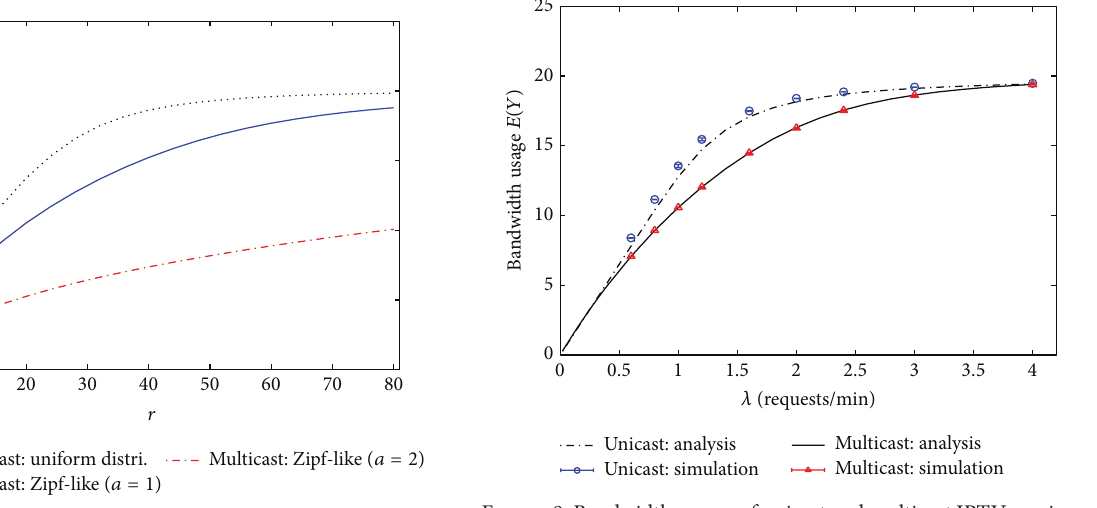
Figure 7: Bandwidth usage of multicast IPTV services under different hit rate distributions.